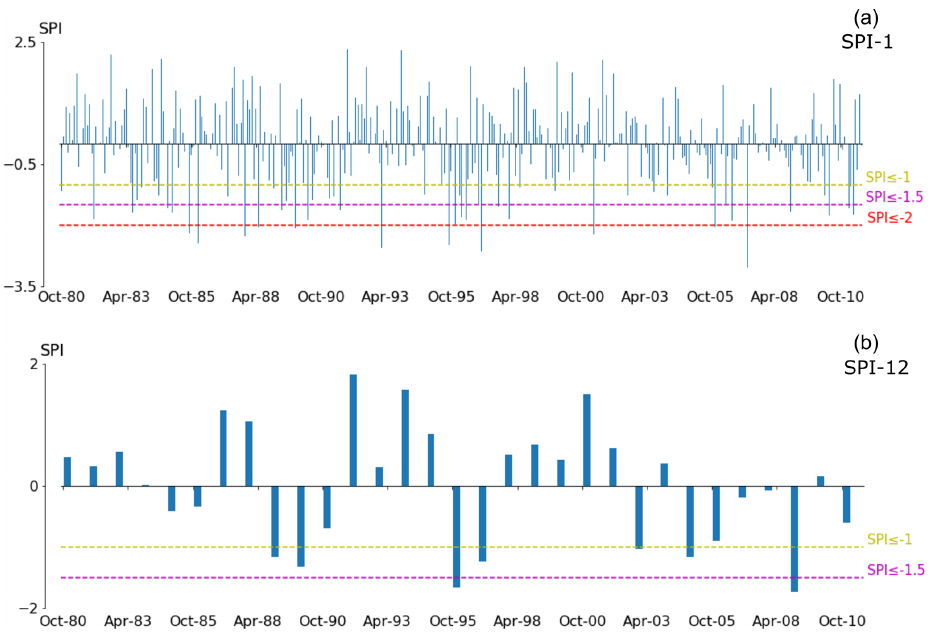
Figure 7. Meteorological drought severity for Doode Bemde nature reserve based on (a) SPI-1 value and (b) SPI-12 value between the hydrological years of 1980 and 2011.